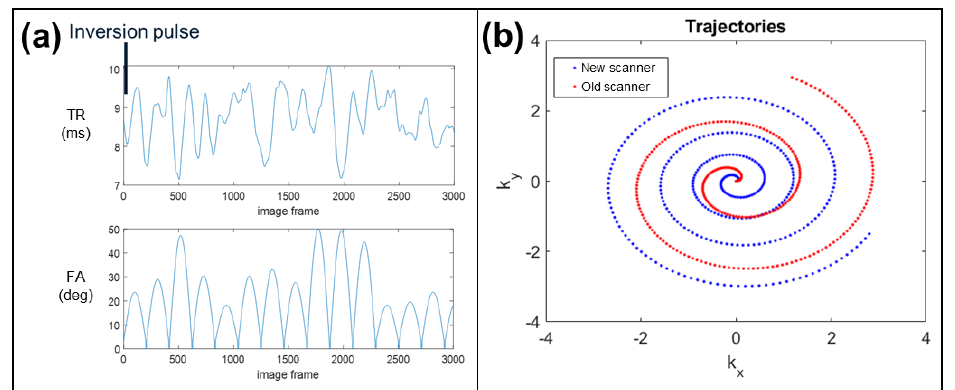
Figure 1. MRF sequence and k-space sampling trajectories. ( a ) For both scanners, the MRF sequence identically uses a variable repetition time (TR) and flip angle (FA) to induce sensitivity to T 1 and T 2 relaxation times. An inversion preparation pulse is applied prior to the first excitation. ( b ) Variable density spiral sampling trajectories are used on both scanners. The ‘weak gradient’ spiral designed for the old scanner MRF implementation (red) is more uniform than the ‘strong gradient’ spiral used for the new scanner MRF implementation (blue), resulting in a higher average acceleration factor (42 vs. 32, respectively).